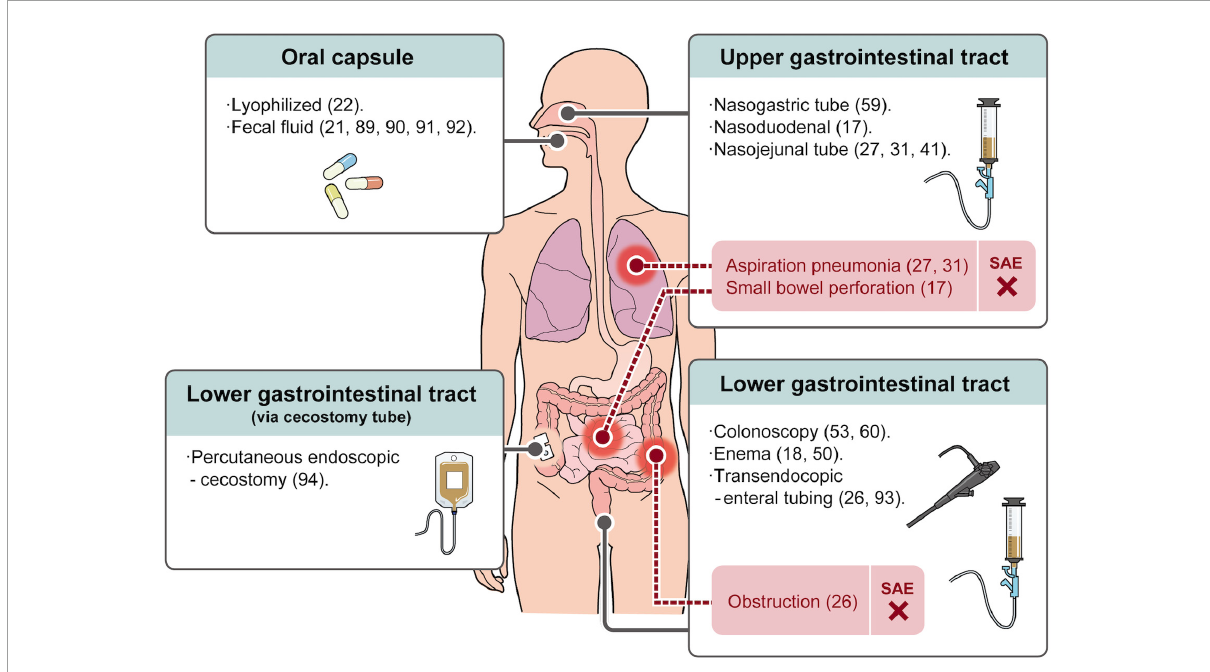
FIGURE1 Route administration of FMT for IBD treatment and serious adverse events